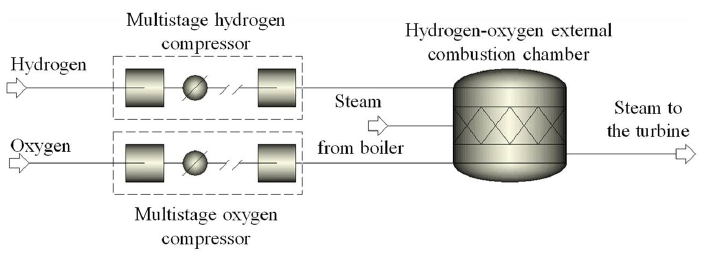
Figure 4. Aspen Plus simulation model of the HCC with multi-stage compressors.